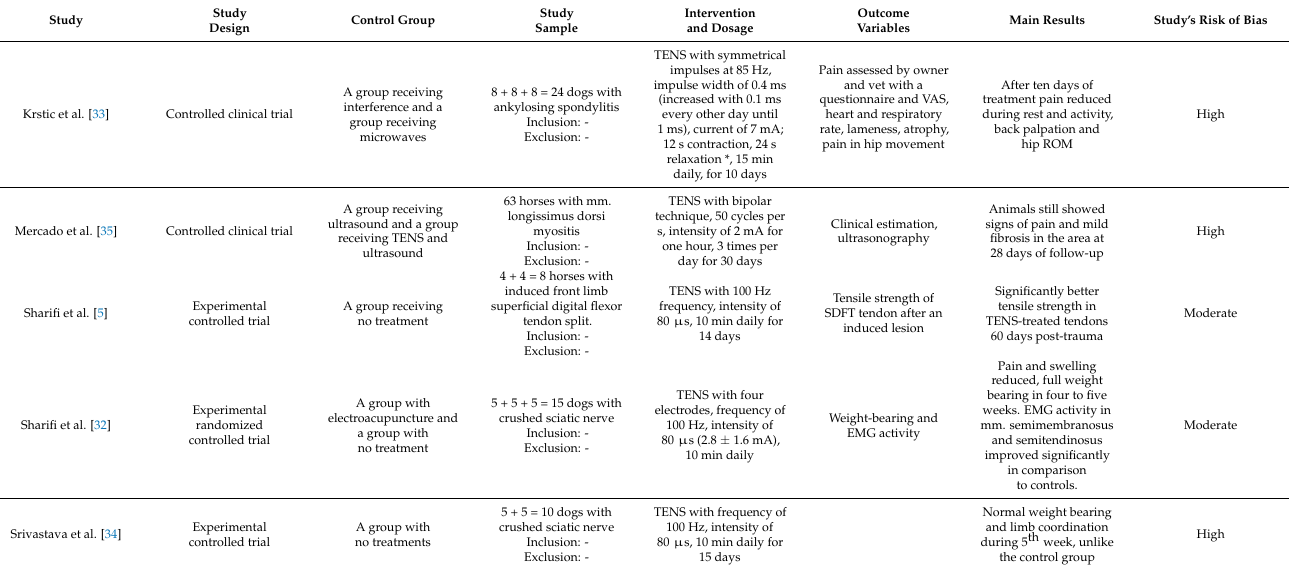
Table 4. Review of articles regarding transcutaneous electrical